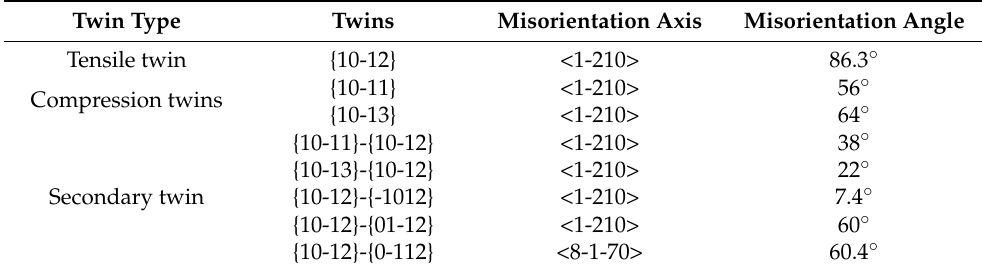
Table 1. Twins and their misorientations relative to the matrix in Mg [27].